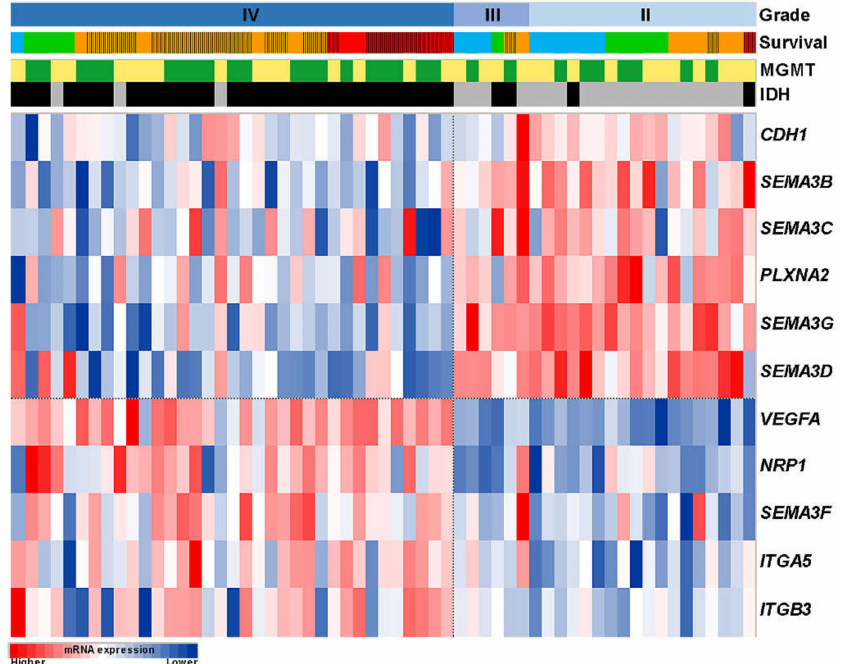
Figure 2. The heatmap of mRNA levels of SEMA3 signaling members in astrocytomas. Expression levels of 11 (out of 19) genes were significantly associated with the tumor grade (Kruskal-Wallis Test, p < 0.05). Survival (patient survival time after surgical resection of the tumor): red color—patients survived less than 1-year, orange—patients survived 1-year, green—survived 2-years, and blue—survived 3-years, strait lines indicate patients who are dead, others are censored; MGMT : yellow color—methylated, green—unmethylated; IDH : grey—mutation,